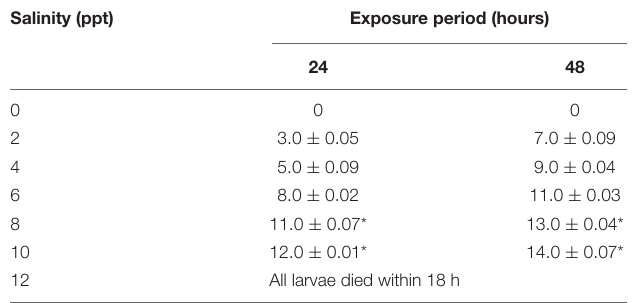
TABLE 4 | Percent (%) abnormalities of larvae of striped catfish in different salinities ( n = 150 larvae). Salinity